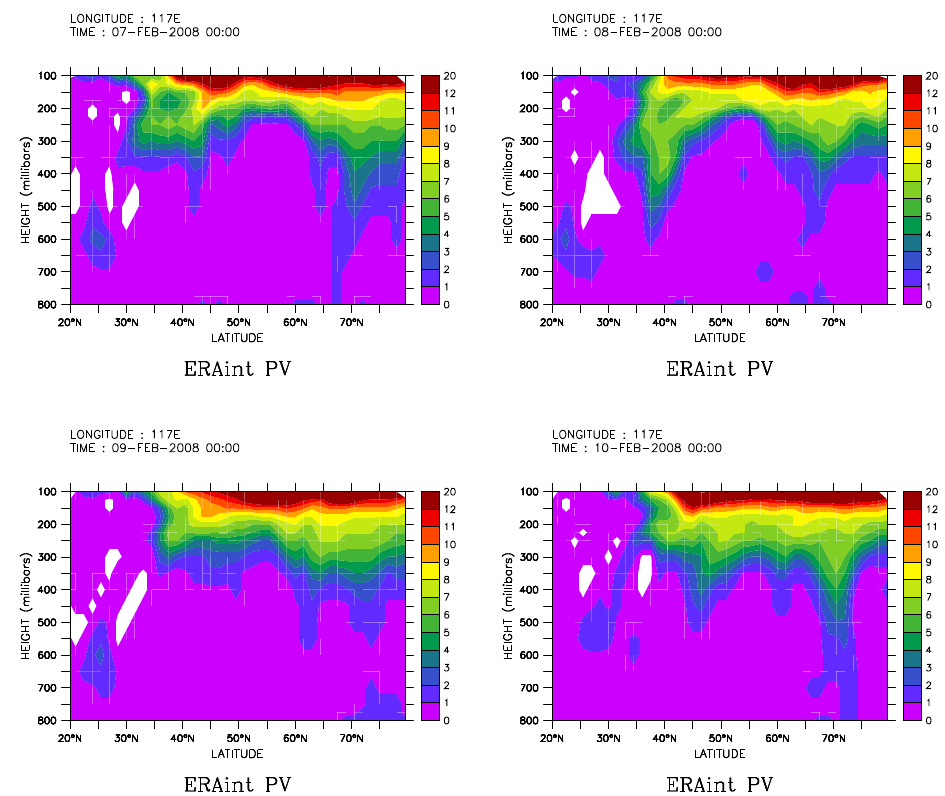
Fig. 14. Cross-sections of PV against latitude at 117 ◦ E longitude from 7 to 10 February taken from ECMWF ERA interim database.